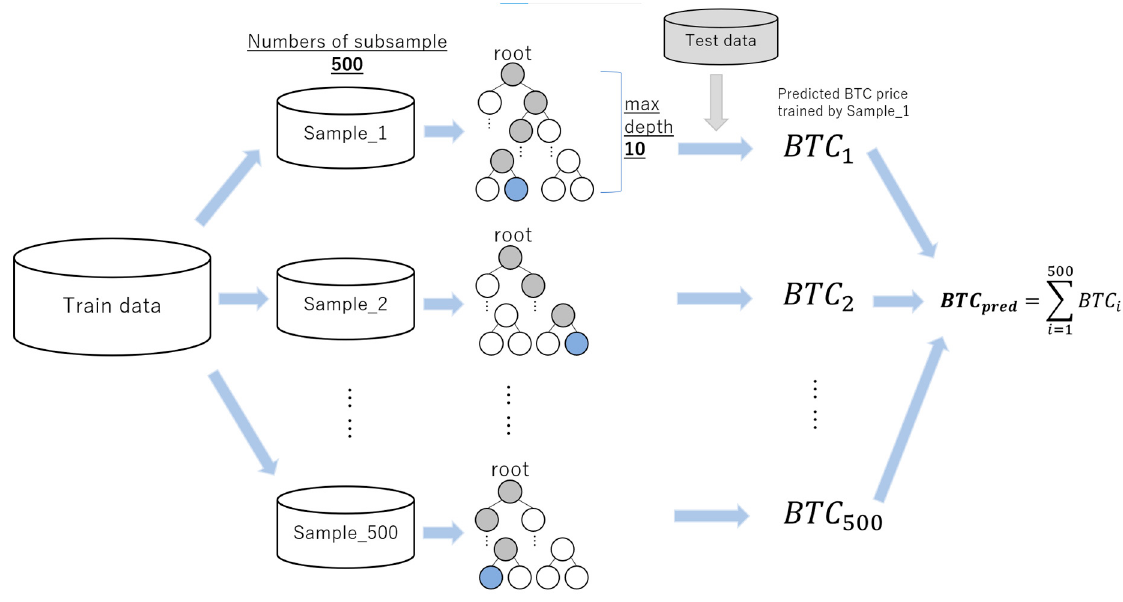
Figure 1. Parameters and framework of random forest